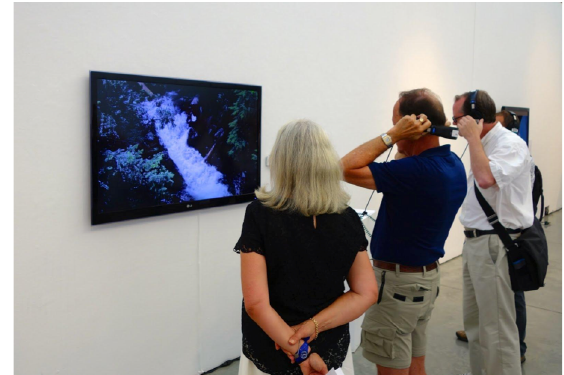
Figure 4 | MediaScape in installation with viewers listening to separate generative audio